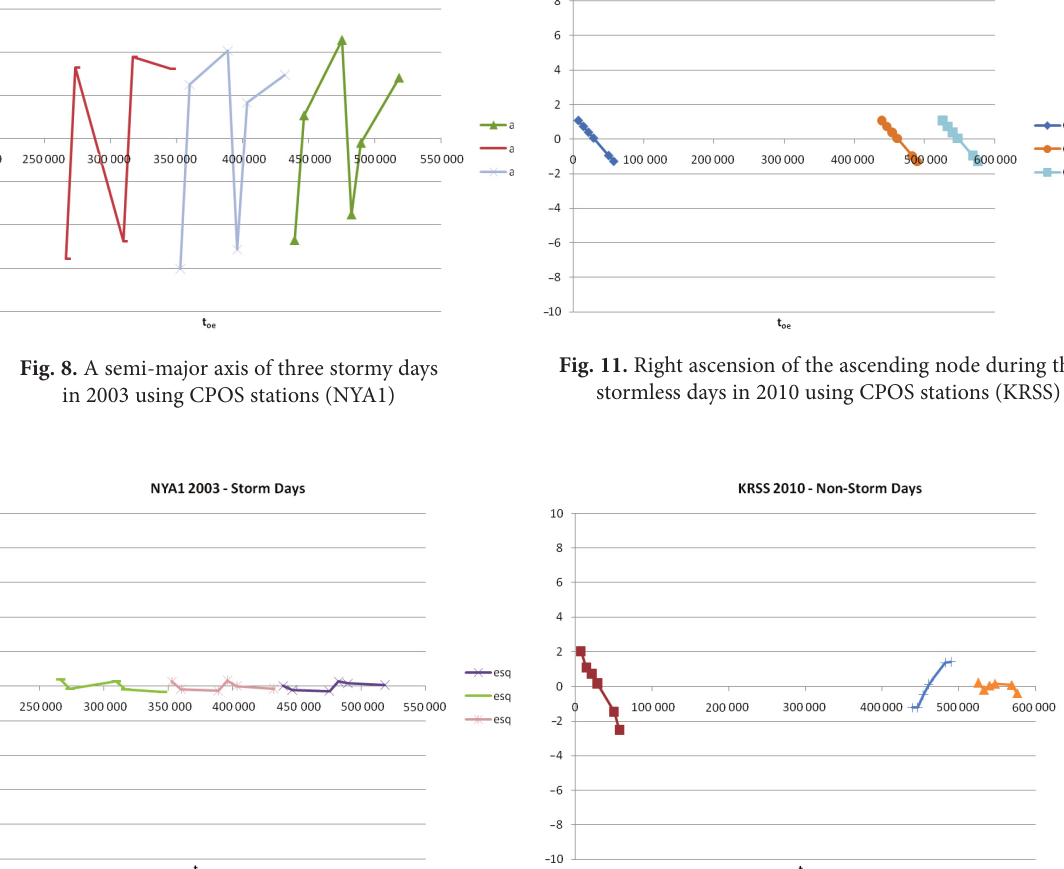
Fig. 9. The eccentricity of three stormy days in 2003 using cPOS stations (NYa1)